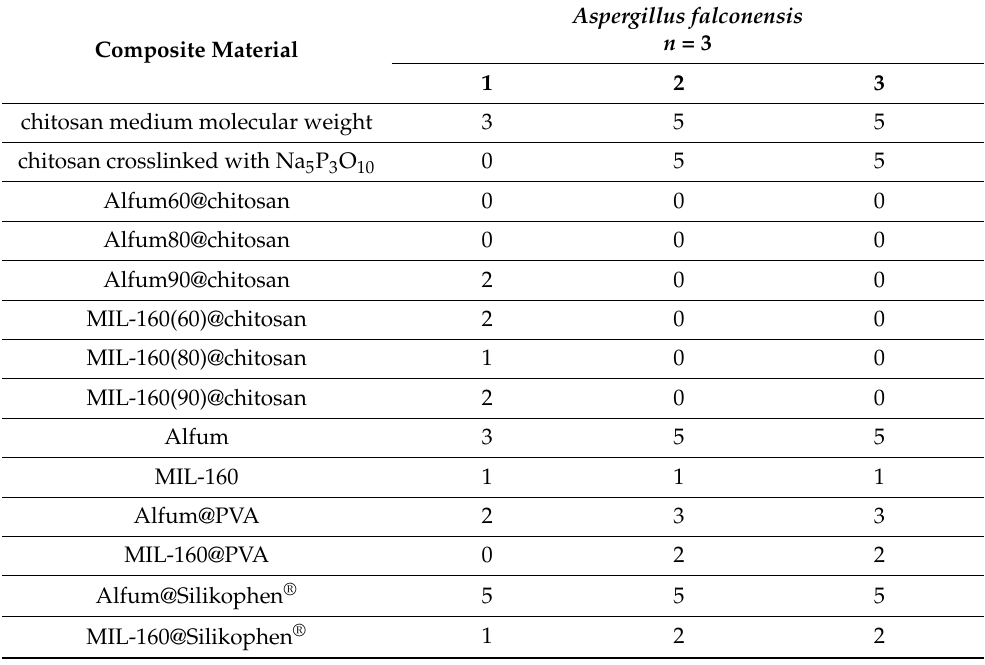
Table 4. Comparison of the results of the tests for microbial metabolism for Aspergillus falconensis .